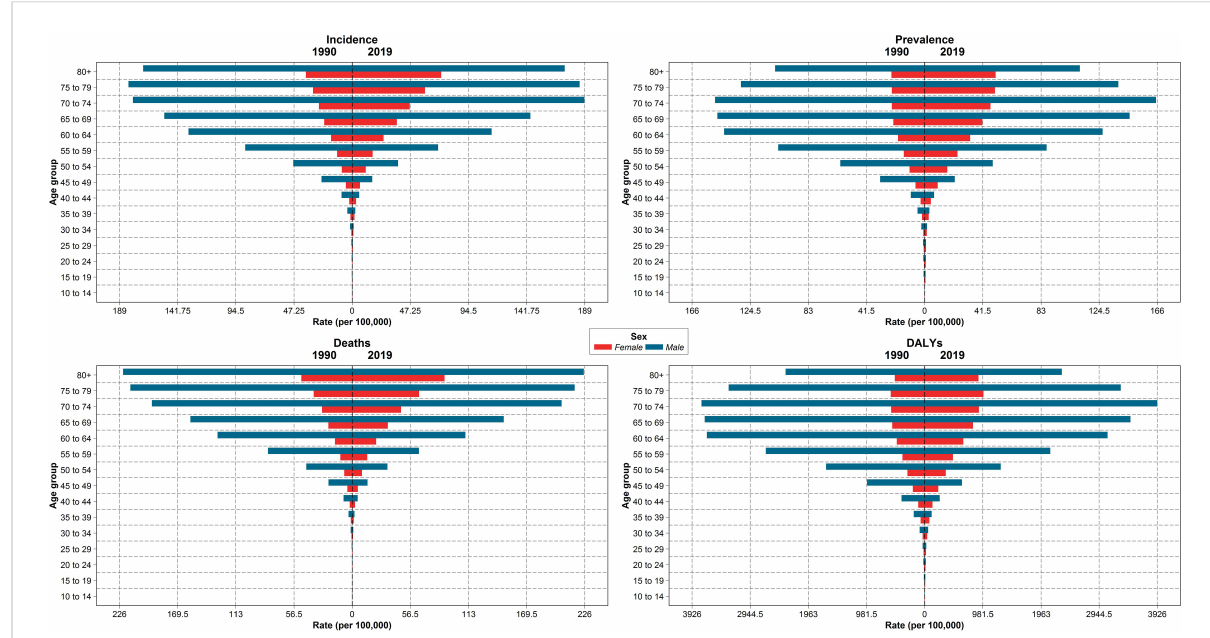
FIGURE 2 The incidence, prevalence, deaths, and DALY rates by age groups and sex in region, 1990 compared with 2019 DALYs = disability-adjusted life years .